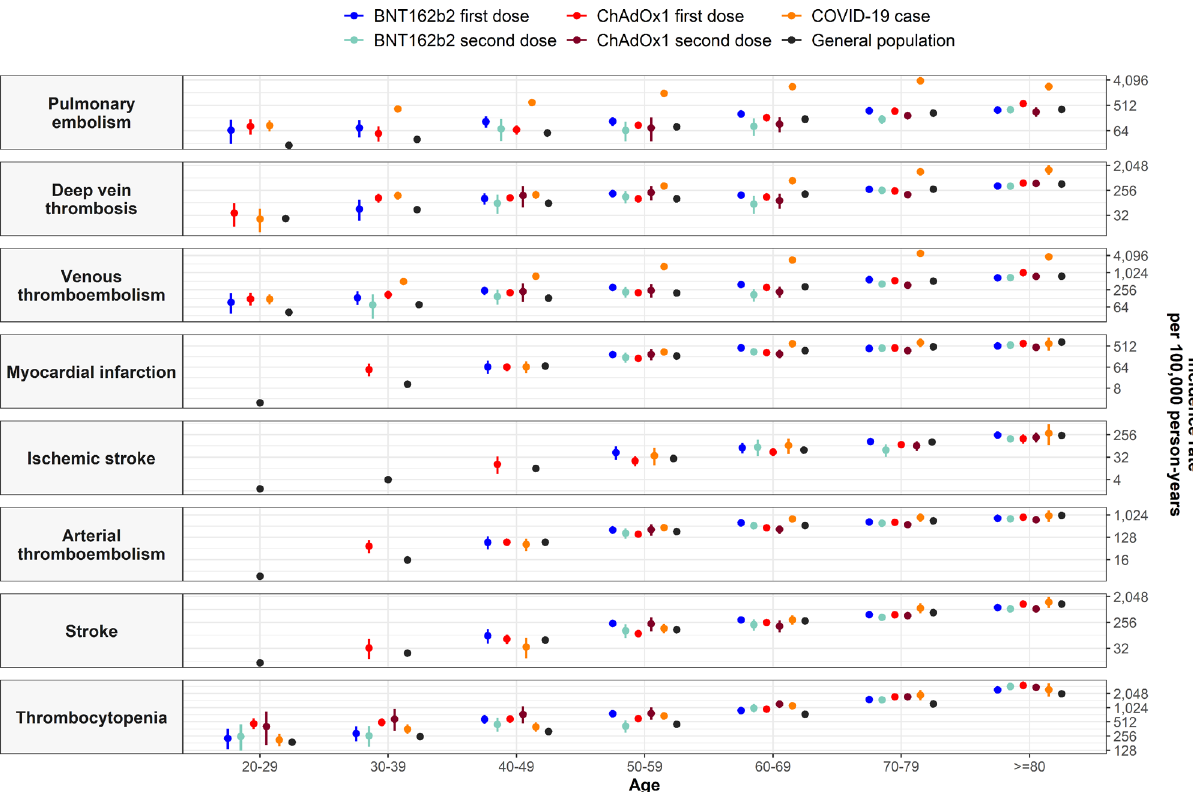
Fig. 3 | Incidence rate ratios (IRRs) for thromboembolic events and thrombocytopenia by age. Events with less than 5 occurrences have been omitted for privacy reasons. Point estimates with 95% con fi dence intervals.